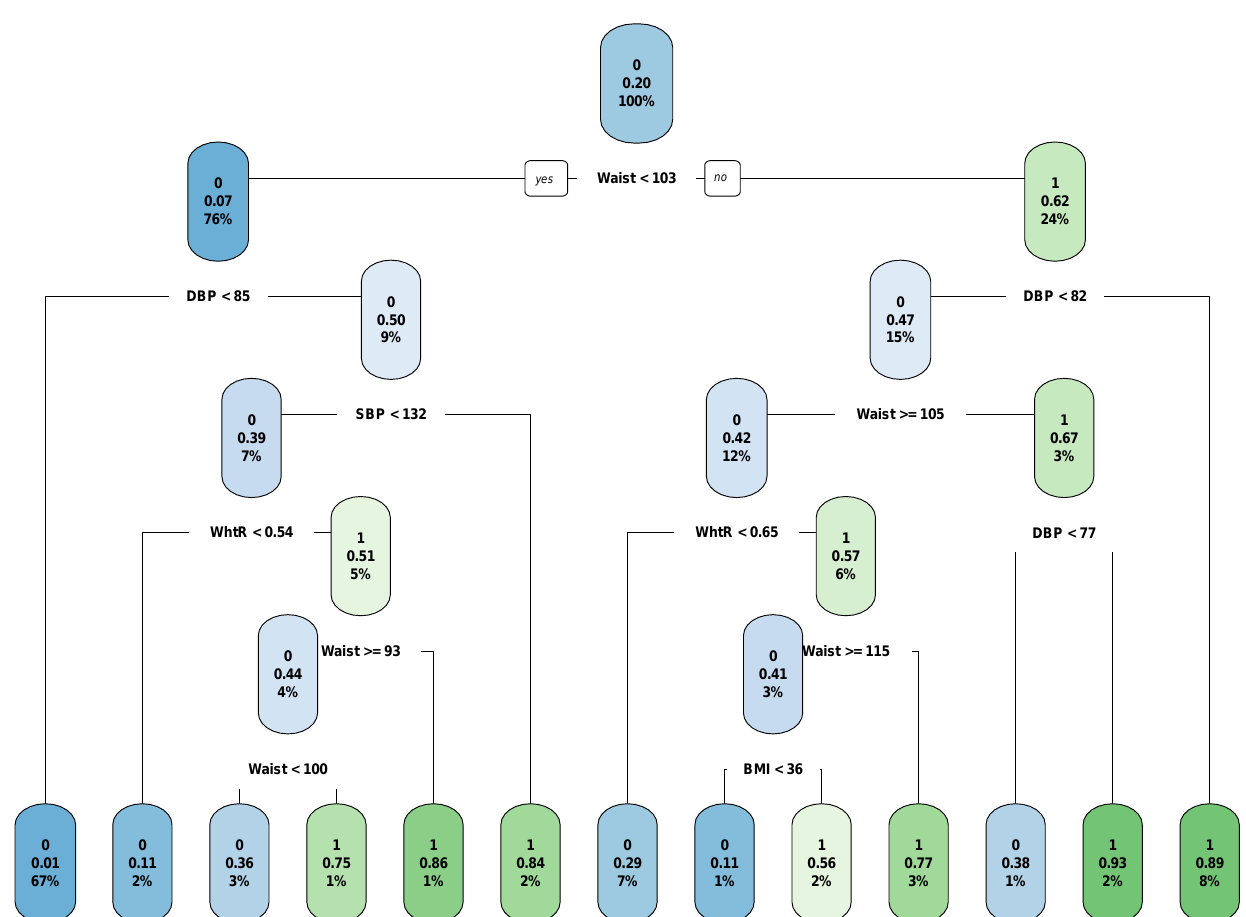
Figure 4. Best predictive model built with C4.5 for men across 30 independent